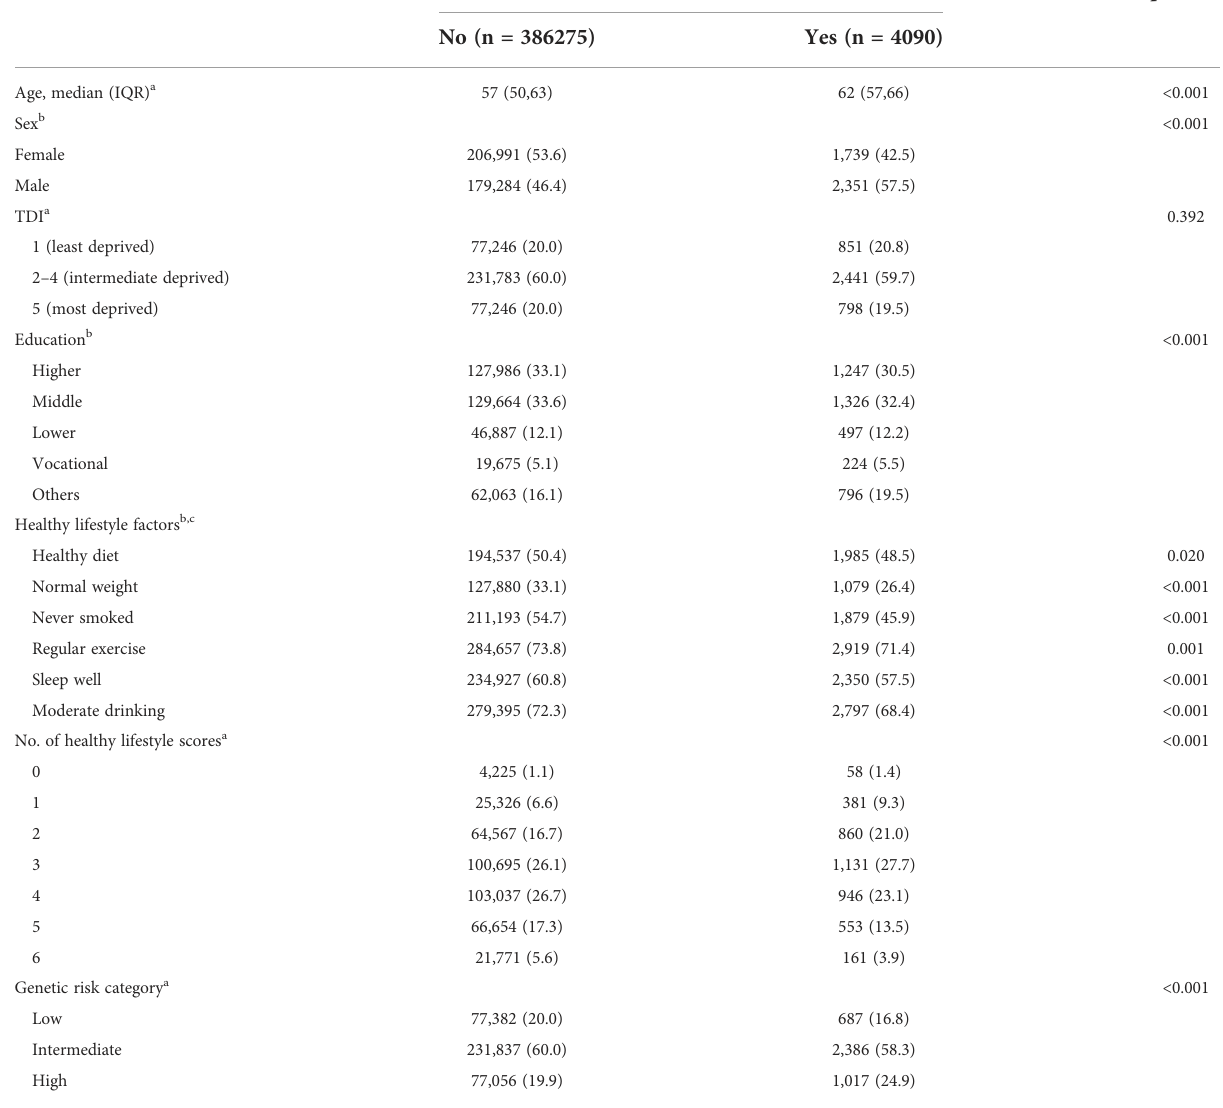
TABLE 1 Baseline characteristics of the study participants by CRC